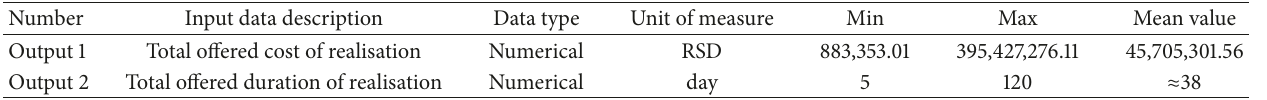
Table 5: Outputs from the